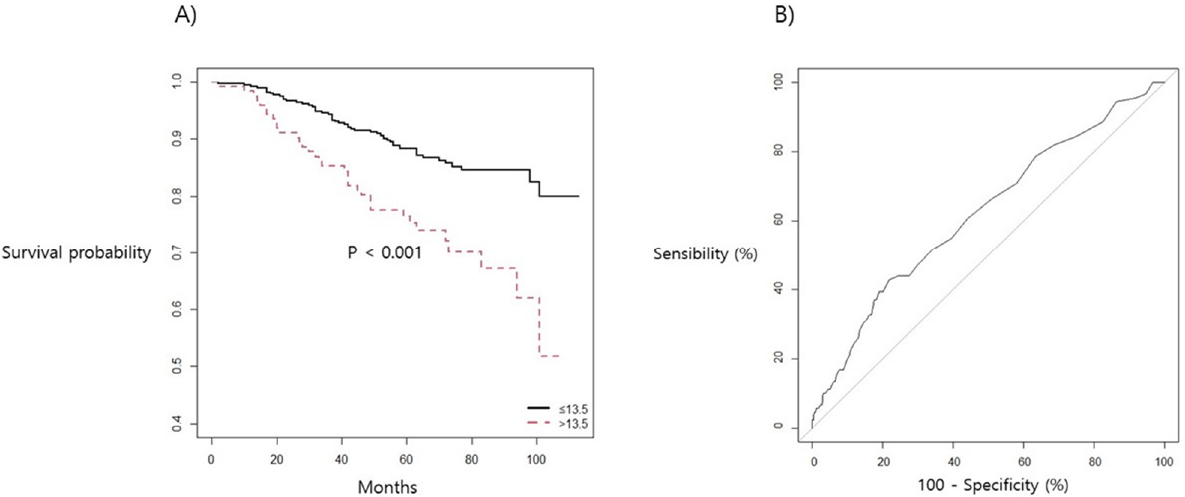
Figure 3. ( A ) Kaplan–Meier survival curve and ( B ) ROC curve for postoperative mortality in association with RDW in patients with breast cancer surgery.